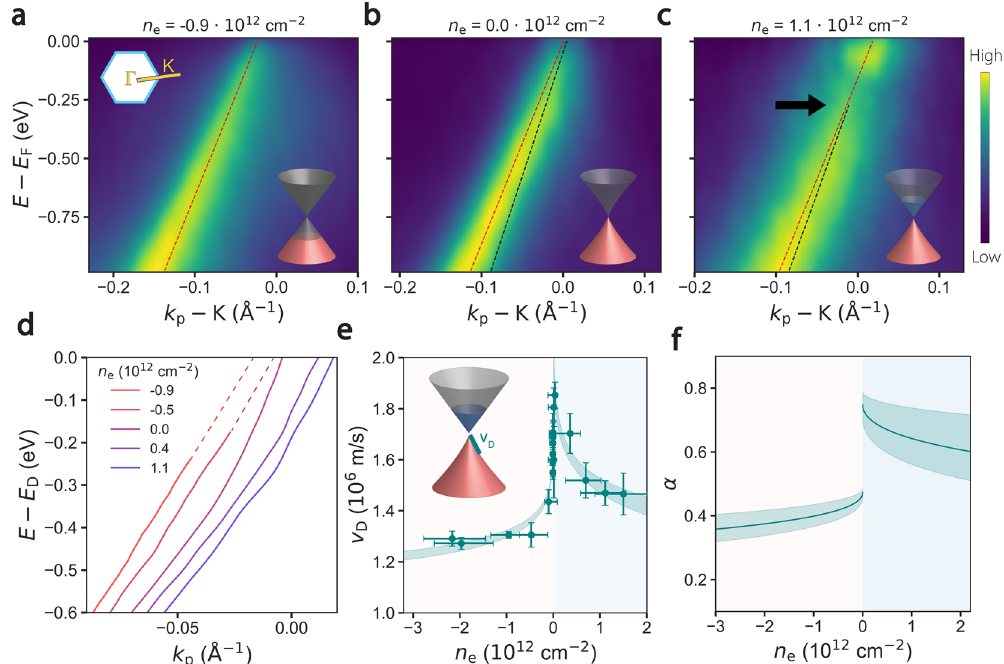
Fig. 2 Electron-hole asymmetry in graphene dispersions. ( a.-c .) graphene spectra at three representative dopings: ( a .) − 0.9 ⋅ 10 12 cm − 2 , ( b .) 0.0 ⋅ 10 12 cm − 2 , ( c .) 1.1 ⋅ 10 12 cm − 2 . Black (red) dashed lines indicate linear fi ts to dispersions near E D ( E F in ( a )). Inset cartoons illustrate the deviations from Dirac cone dispersions at respective dopings. ( d .) E D dispersions near the charge neutrality point indicate asymmetry in band velocity for electron and hole dopings. ( e .) Extracted band velocities as a function of doping. Error bars indicate 1 σ deviation of best fi t to graphene dispersions. ( f .) Graphene fi ne structure constant ( α ) as a function of doping, is extracted from band velocity fi ts. Teal shaded regions indicate 1 σ deviation of best fi t to the v D data using the logarithm-based lineshape described in the